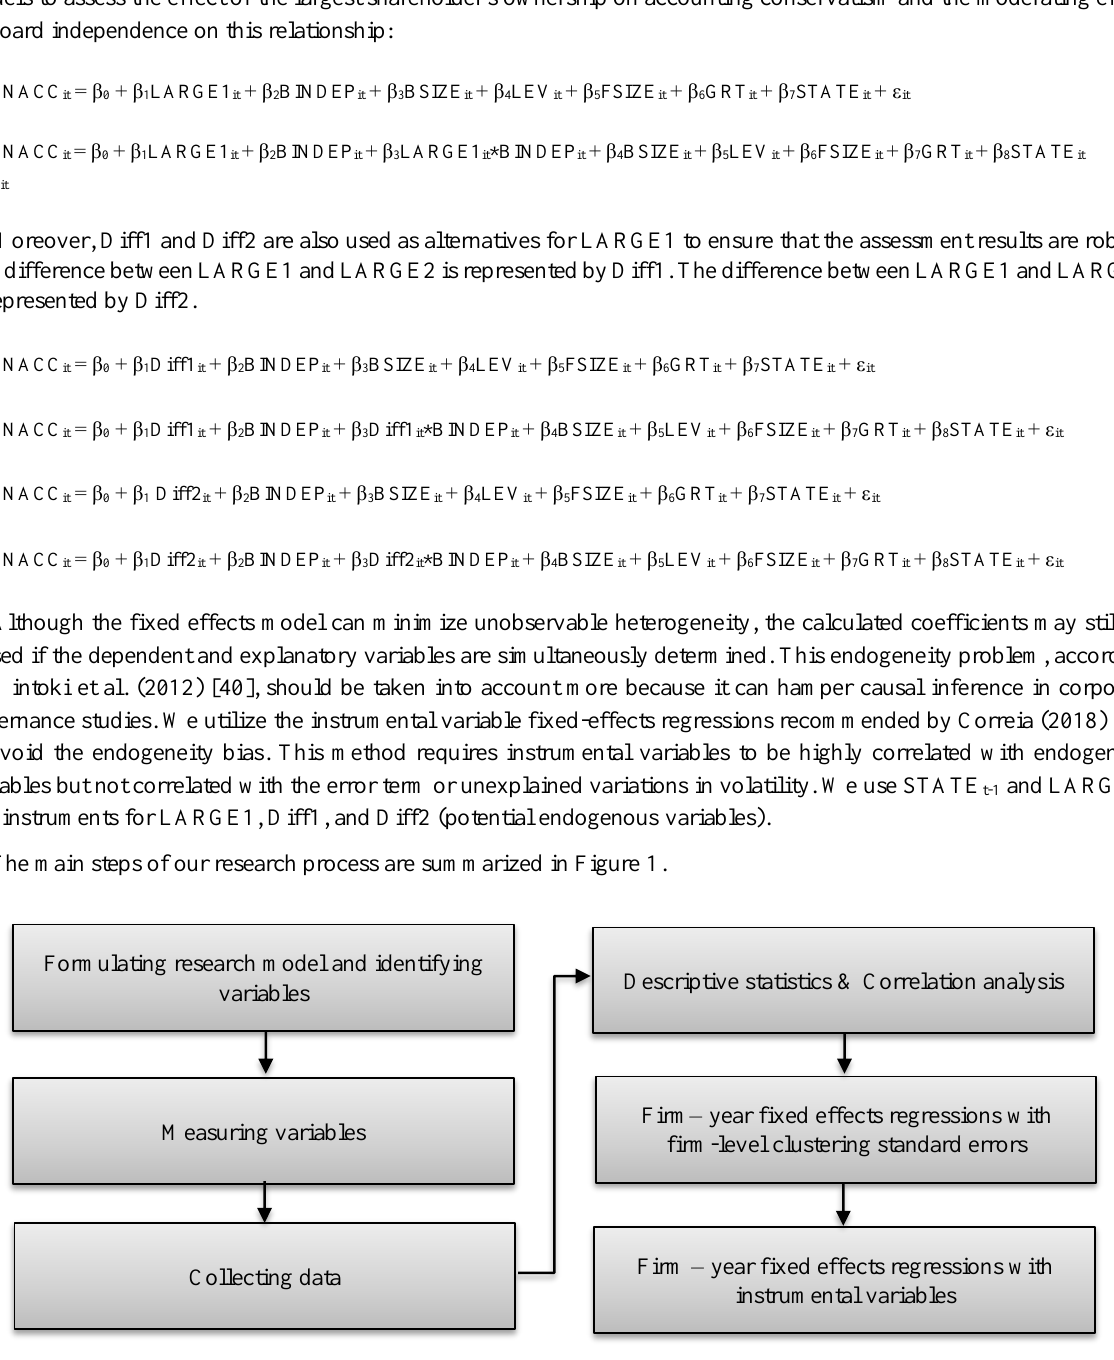
Figure 1. Flowchart of the research